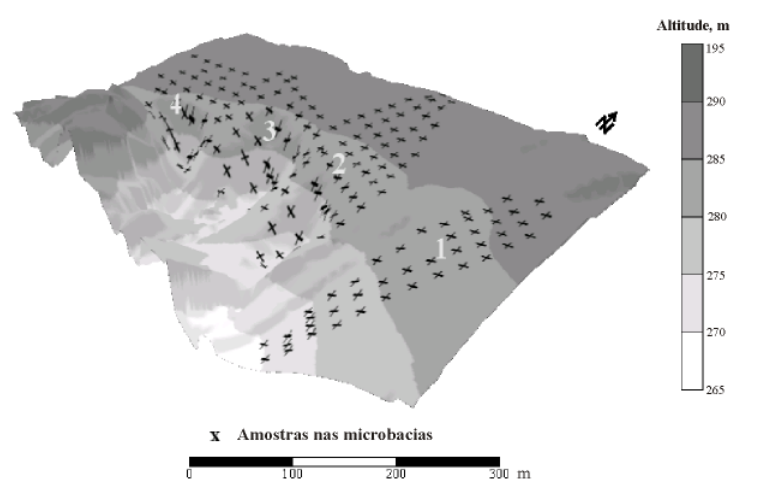
Figura 2. Modelo digital da paisagem das microbacias